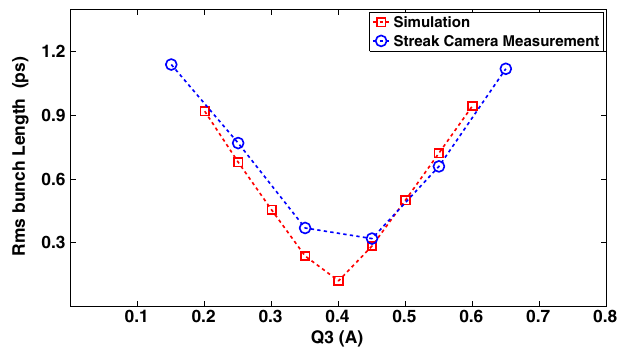
FIG. 12. Comparison of bunch lengths of the electron beam measured at X24 using a streak camera as a function of quad- rupole (Q3) current versus those of simulation using BEAMLATTICE . The chirp was set to (cid:4) 40 degrees off